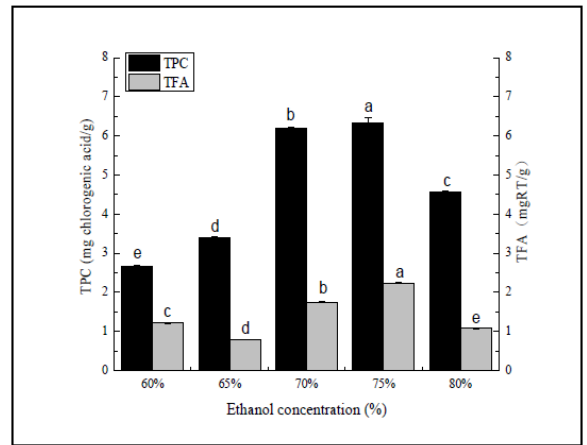
Figure 1. Ethanol concentration (%). Three independent experiments were carried out for each analysis. Result is expressed as a mean ± SD ( n = 3). Values with the different letters in the column are significantly different by Duncan’s multiple range test ( p < 0.05). are significantly different by Duncan’s multiple range test ( p <